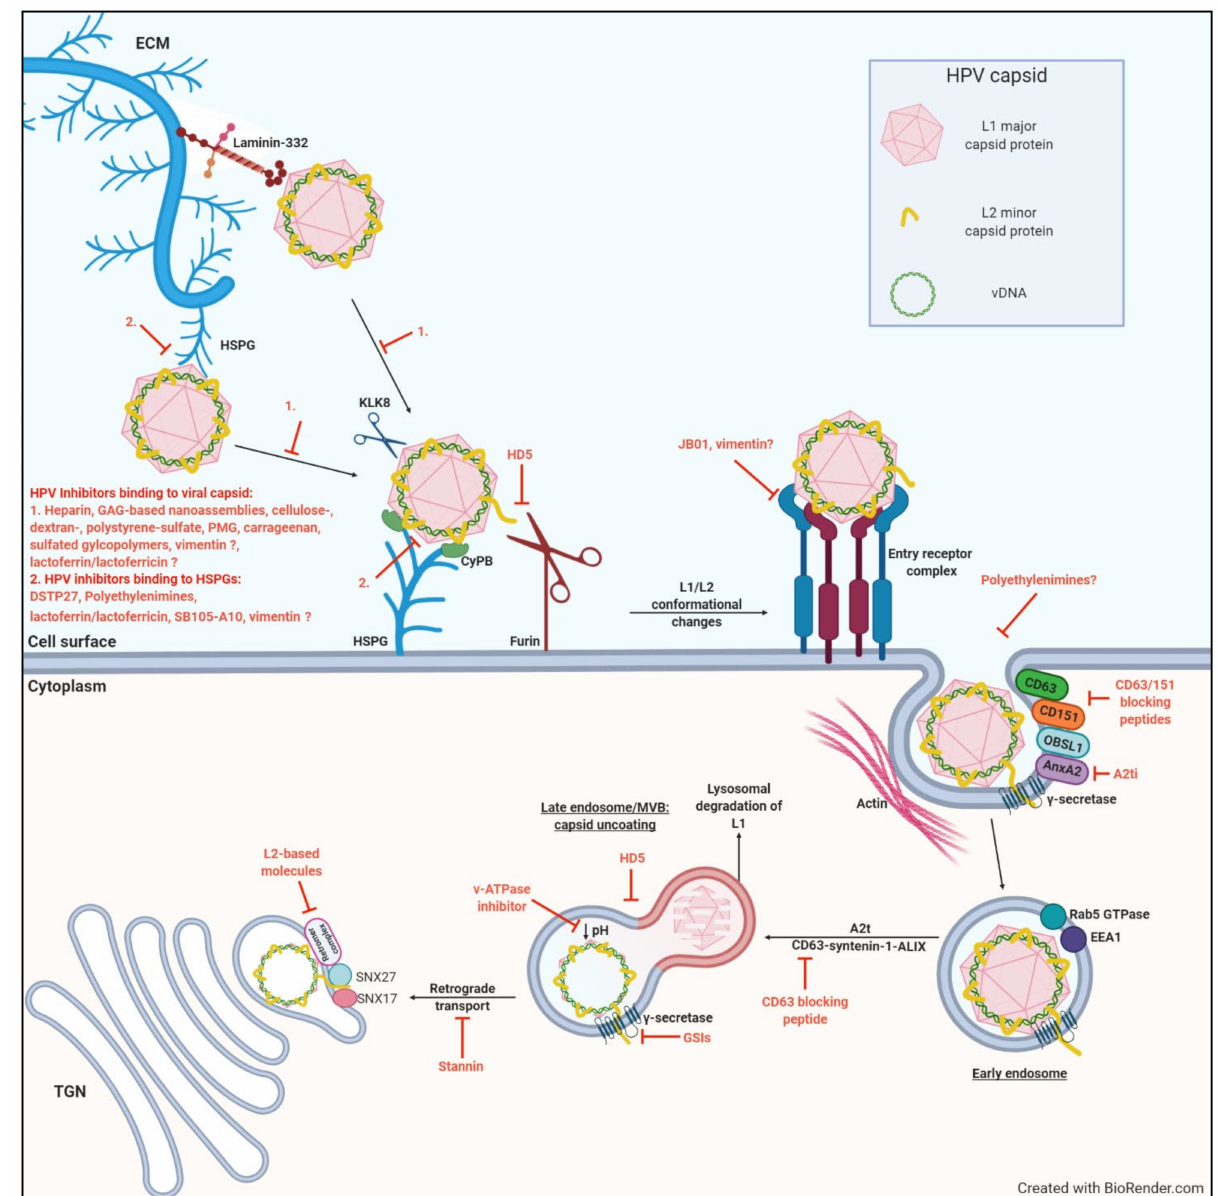
Figure 1. Schematic illustration of the early stages of human papillomavirus (HPV) infection, indicating the sites of inhibition of various anti-HPV molecules. Briefly: binding to heparan sulfate proteoglycans (HSPGs) results in conformational changes of the viral capsid, which facilitates interactions between the capsid and cyclophilin B (CyPB) and cleavage by kallikrein-8 (KLK8). This results in the exposure of the L2 N-terminus, containing a conserved site which is cleaved by furin. This is followed by dissociation of the capsid from HSPGs and exposure of a binding site in L1, potentially needed for recognition by an unknown entry receptor complex. The viral capsid undergoes ligand induced endocytosis (which is clathrin-, caveolin-, cholesterol- and dynamin-independent) and depends on the reorganization of the actin cytoskeleton. Membrane protrusion of the L2 capsid protein is chaperoned by γ -secretase, which allows L2 to interact with host cell factors in the cytosol during transport. HPVs localize with early antigen 1 (EEA10) compartments in a Rab5 GTPase-dependent manner. The early endosome matures into the late endosome when it fuses with lysosomes. Lysosomal degradation is driven by the formation of multivesicular bodies (MVBs). Most of the contents are degraded by lysosomal degradation, including the majority of the L1 capsid protein. Endosomal escape and subsequent post-endocytic trafficking of high-risk HPVs is regulated by CD63-syntenin-1-ALIX, which traffics HPV to these multivesicular endosomes. Here, the capsids disassemble in a pH-dependent manner, and egress from the late endosome. The L2/vDNA cargo enters the TGN, where the protruding L2 protein interacts with SNX17, SNX27 and retromer